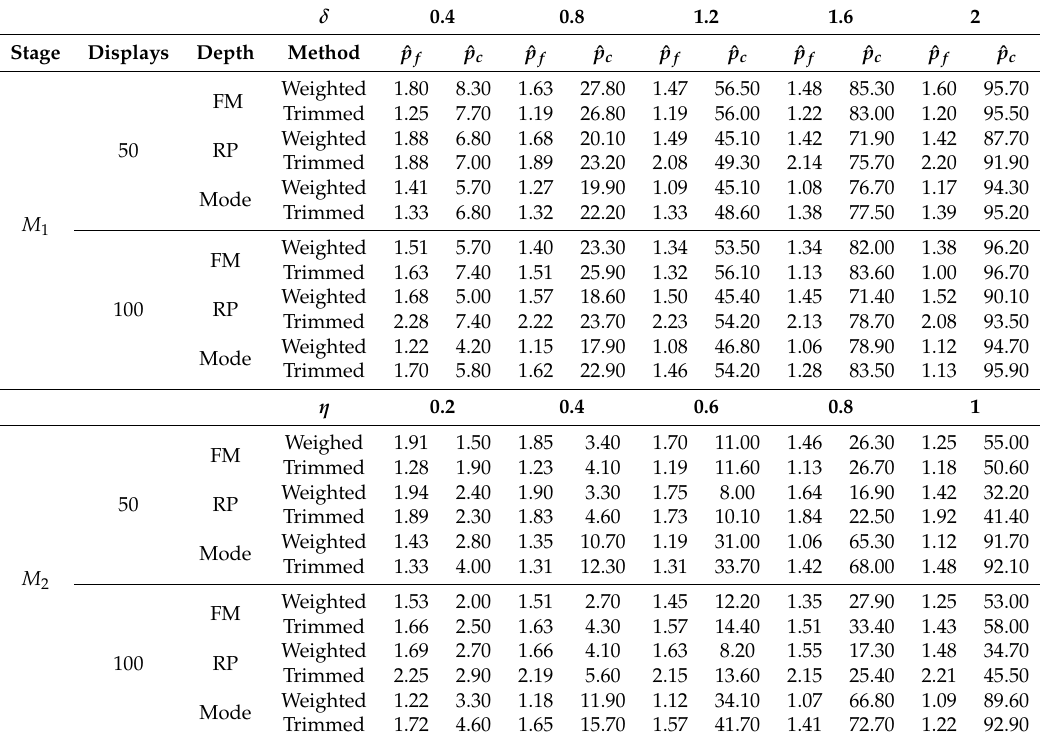
Table 2. Percentages of ˆ p c and ˆ p f for the cases of curves simulated with M 1 (Equation (5)) and M 2 (Equation (6)) models, assuming independence between curves.